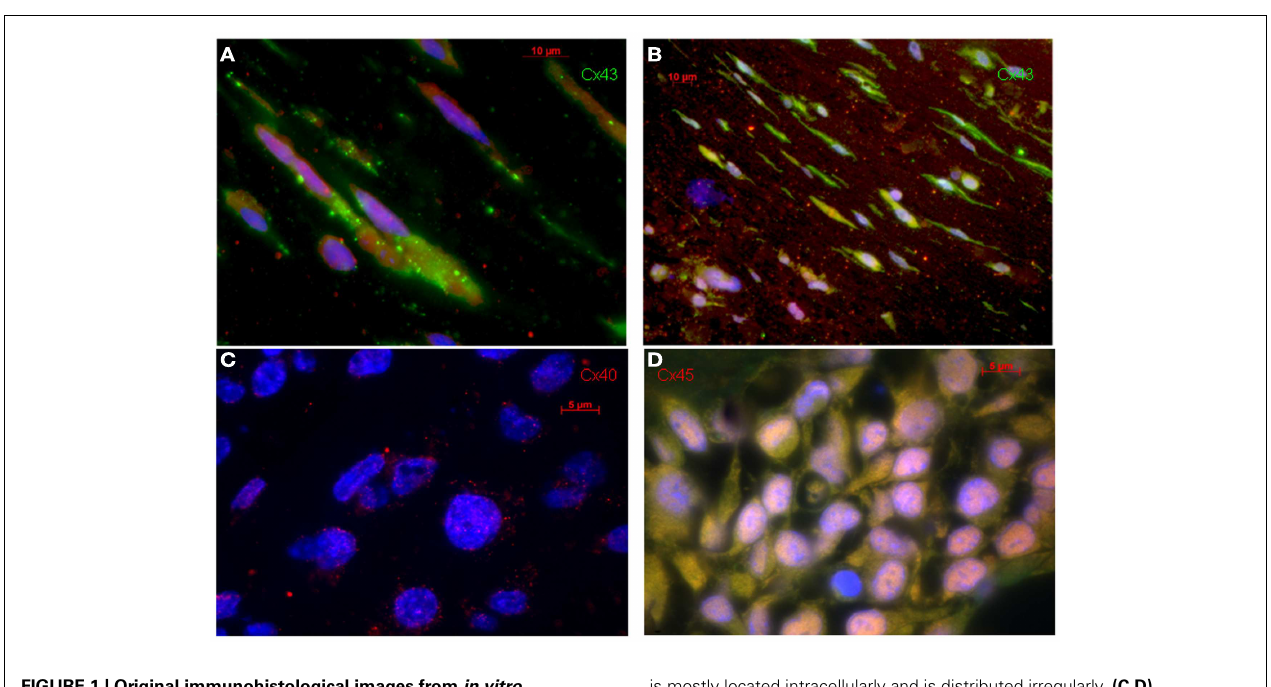
FIGURE 1 | Original immunohistological images from in vitro MSC-ETs. (A) sMSC-ET and (B) cMSC-ET. Red: troponin I, green: Cx43, blue: DAPI. In both types no cross striation for troponin I can be seen.There are numerous cells expressing Cx43. However, Cx43